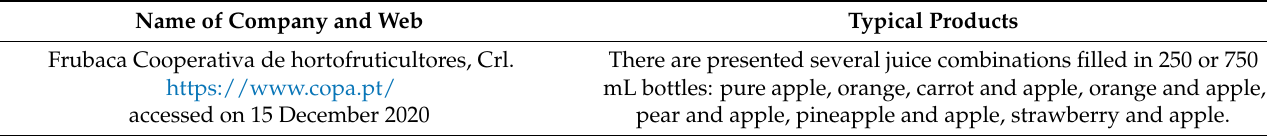
Table A6. High pressure treated products by the company Frubaca Cooperativa.